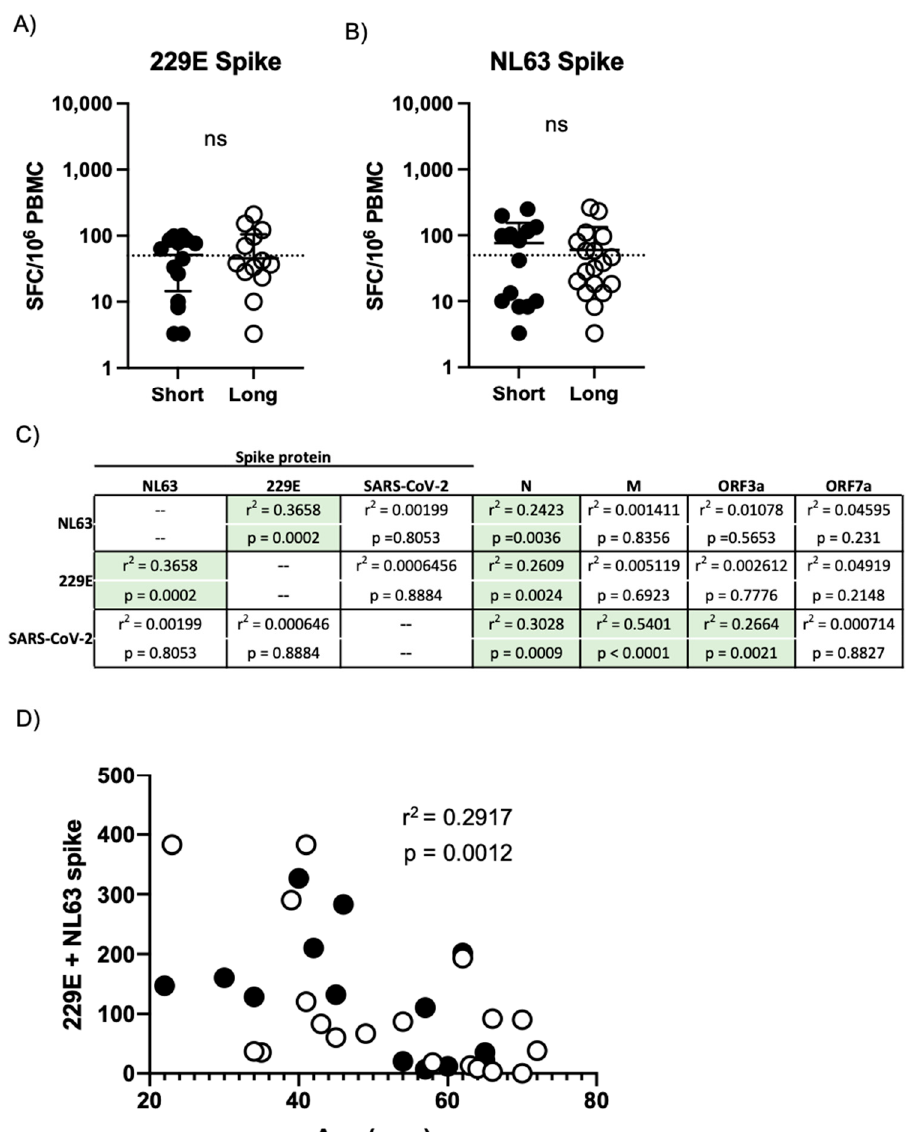
Figure 5. Assessment of seasonal human coronavirus cellular immunity in convalescent COVID-19 donors. ( A ) Magnitude of 229E spike protein-specific cellular immunity in all study participants split by duration of self-report COVID-19 symptoms. ( B ) Magnitude of NL63 spike protein-specific cellular immunity in all study participants split by duration of self-report COVID-19 symptoms. ( C ) Correlation table assessing the relationship between NL63, 229E, and SARS-CoV-2 spike protein reactivity in all subjects and the magnitude of reactivity against other human coronavirus antigens included in the study. r 2 and p value calculated by 2-tailed Pearson Correlation test. ( D ) Relationship between subject age and total 229E/NL63 spike protein-specific cellular immune response. Filled circles indicate subjects included in the short duration of symptoms group. Empty circles indicate individuals included in the long duration of symptoms group. r 2 and p value calculated by 2-tailed Pearson Correlation test.